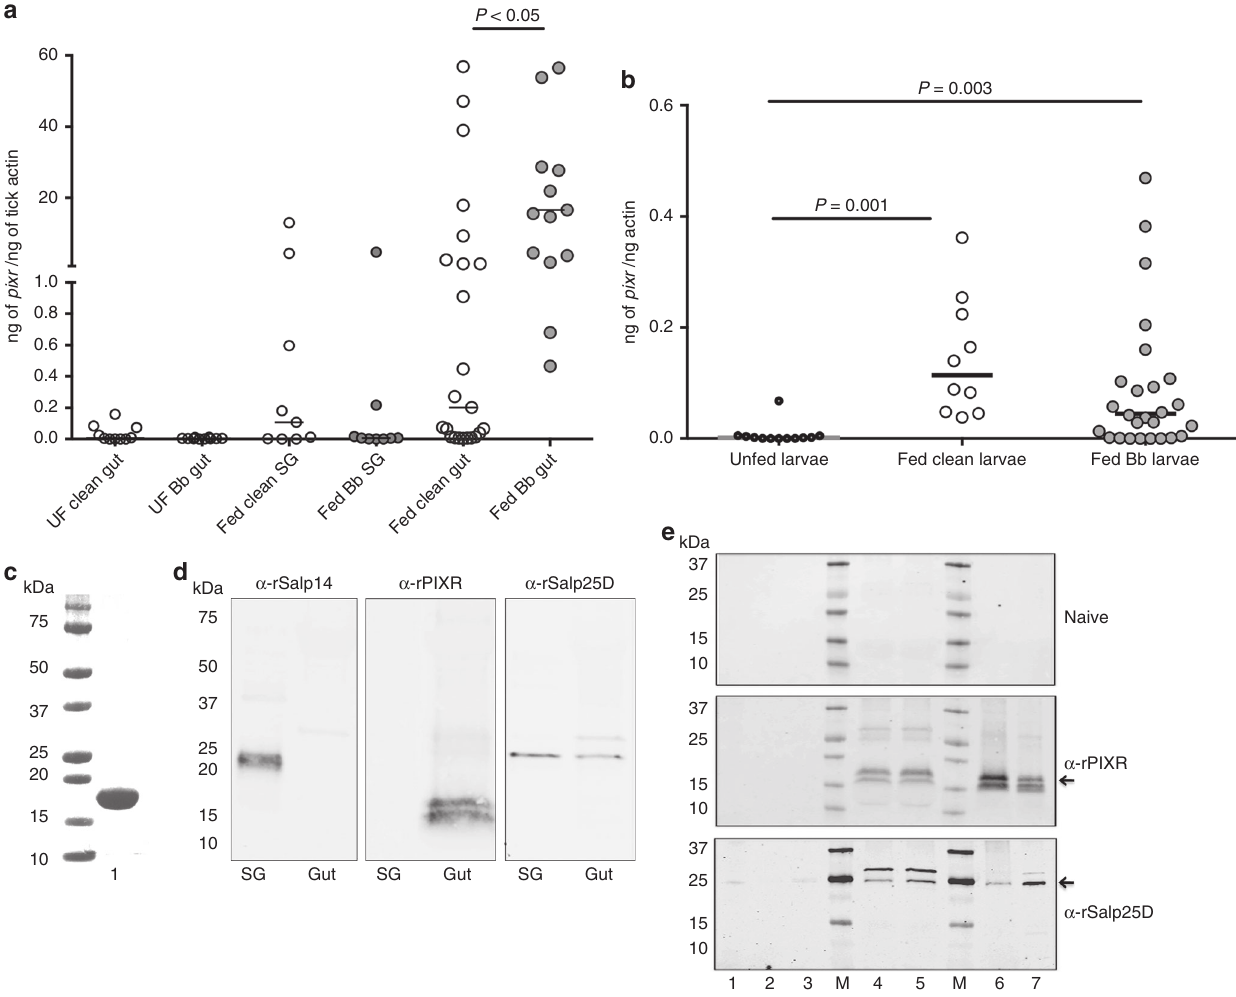
Fig. 2 PIXR is induced upon feeding in I . scapularis nymphs and larvae. Quantitative RT-PCR assessment of pixr transcript levels in: a unfed clean (UF clean gut) and unfed B . burgdorferi -infected (UF Bb gut) gut, fed salivary glands from clean (Fed clean SG) and B . burgdorferi -infected nymphs salivary glands (Fed Bb SG), fed guts of clean (Fed clean guts) and Borrelia -infected (Fed Bb gut) nymphs. Each data point represents a pool of three nymphal salivary glands or guts. b clean unfed larvae (Unfed larvae) and larvae fed on clean (Fed clean larvae) or B . burgdorferi -infected mice (Fed Bb larvae). Each data point represents a pool of fi ve fed larvae; Horizontal bar represents the median. Mean values signi fi cantly different in a non-parametric Mann – Whitney test ( P < 0.05) indicated. c Coomassie blue staining of puri fi ed recombinant PIXR (rPIXR) produced in a Drosophila expression system, lane 1 . Protein markers shown to the left (Precision Plus Biorad protein markers). d Western blot of protein extracts of fed clean nymphal salivary glands (SG) and gut (Gut) probed with polyclonal rabbit anti rSalp14 sera, anti-rPIXR or anti rSalp25D sera. e Replicate western blots of protein extracts of unfed larvae lane 1; unfed B . burgdorferi -infected nymphal gut, lane 2; unfed clean nymphal gut, lane 3; larvae fed on B . burgdorferi -infected, lane 4; or on clean mice, lane 5; guts of fed B . burgdorferi -infected nymphs lane 6; or fed clean nymphs lane 7; probed with polyclonal naive rabbit sera, or polyclonal anti-rPIXR or anti rSalp25D rabbit sera. Protein markers (Precision Plus Biorad protein markers) are shown in lane M and their cognate molecular weights denoted to the left . Arrows indicate PIXR and Salp25D-speci fi c protein bands and has fi ve predicted O -glycosylation sites and four predicted ε - amino group glycation sites. The absence of cross-reacting PIXR3 (predicted molecular mass of ~15.4) in the doublet band suggests low protein expression. No cross-reacting bands corresponding to PIXR 4 and 5 were observed at the predicted sizes of ~7.2 and 10.9 kDa, respectively. Consistent with the qRT-PCR data, PIXR/ PIXR2 protein levels were comparable in larvae that fed on uninfected mice or B . burgdorferi -infected mice, and increased (~1.5-fold) in B . burgdorferi -infected nymphal gut when compared to that in uninfected nymphal guts. Although pixr2 transcripts were observed in unfed larvae (Supplementary Fig. 2A), no speci fi c cross-reactivity to anti-PIXR antibodies were observed.